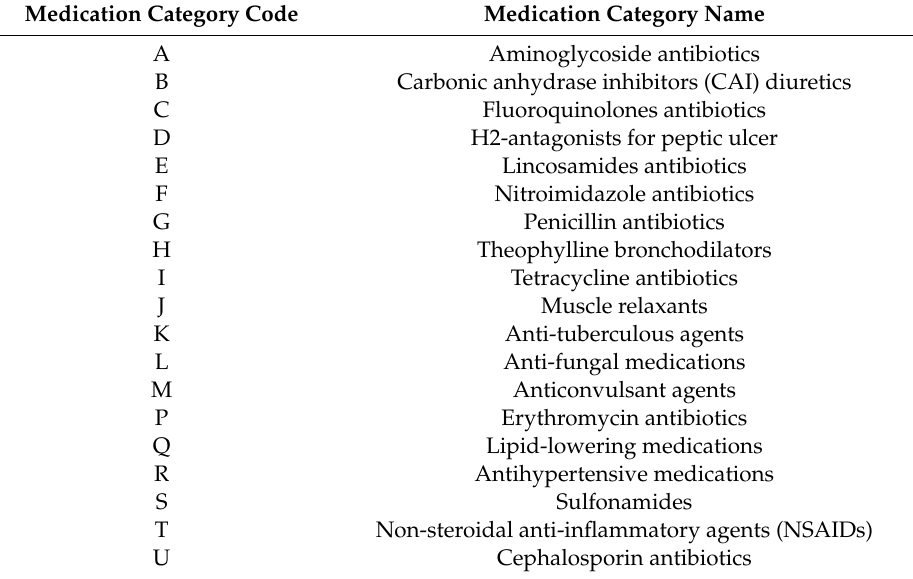
Table 3. List of medication categories.